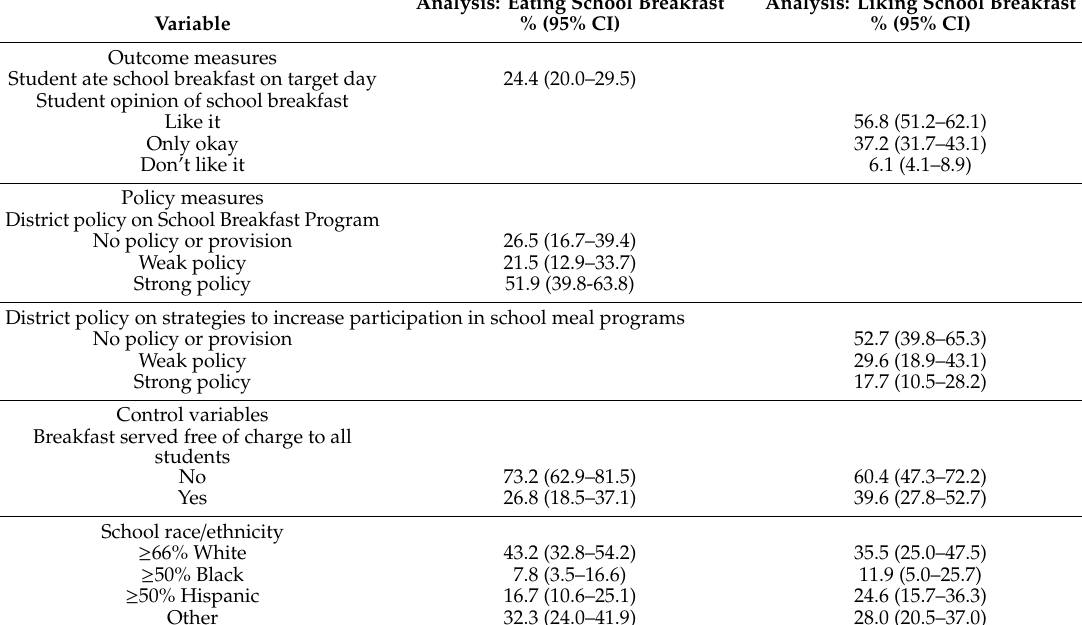
Table 1. Survey-weighted characteristics of analytical samples of students from the School Nutrition and Meal Cost